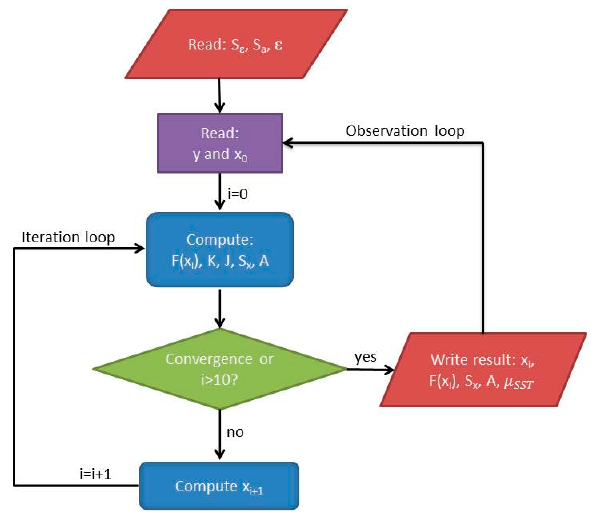
Figure 6. Flowchart of the DMI OE algorithm.